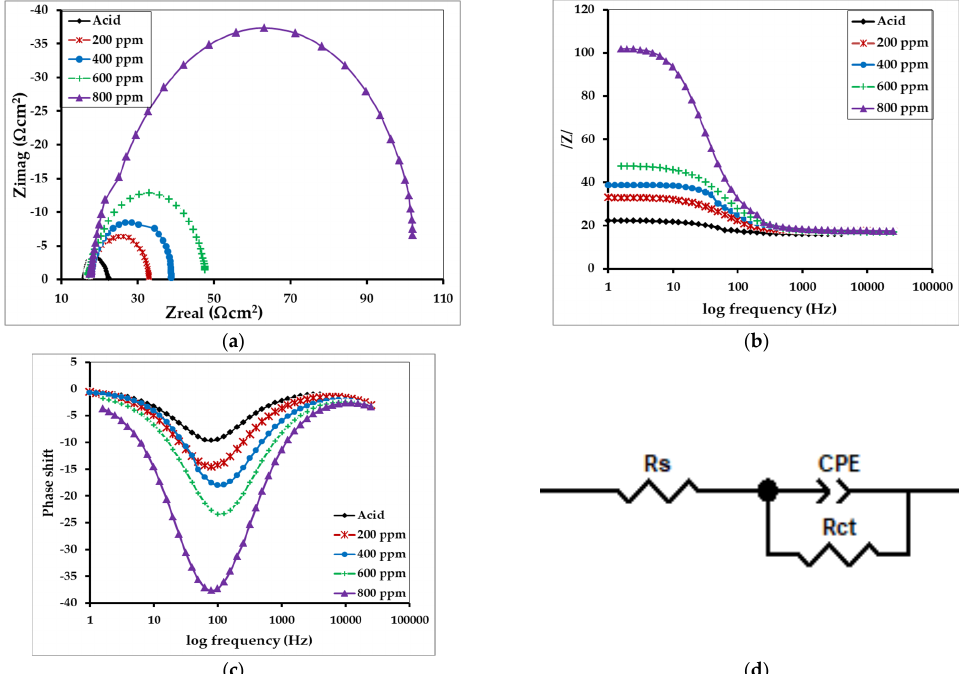
Figure 12. Representing ( a ) Nyquist (Cole-Cole) plot, ( b ) Bode plots, and ( c ) Bode plots of phase shift versus log frequency for the MS in 1 M H 2 SO 4 without and with inhibitors of different concentrations, and ( d ) the equivalent circuit model used to fit the impedance spectra.